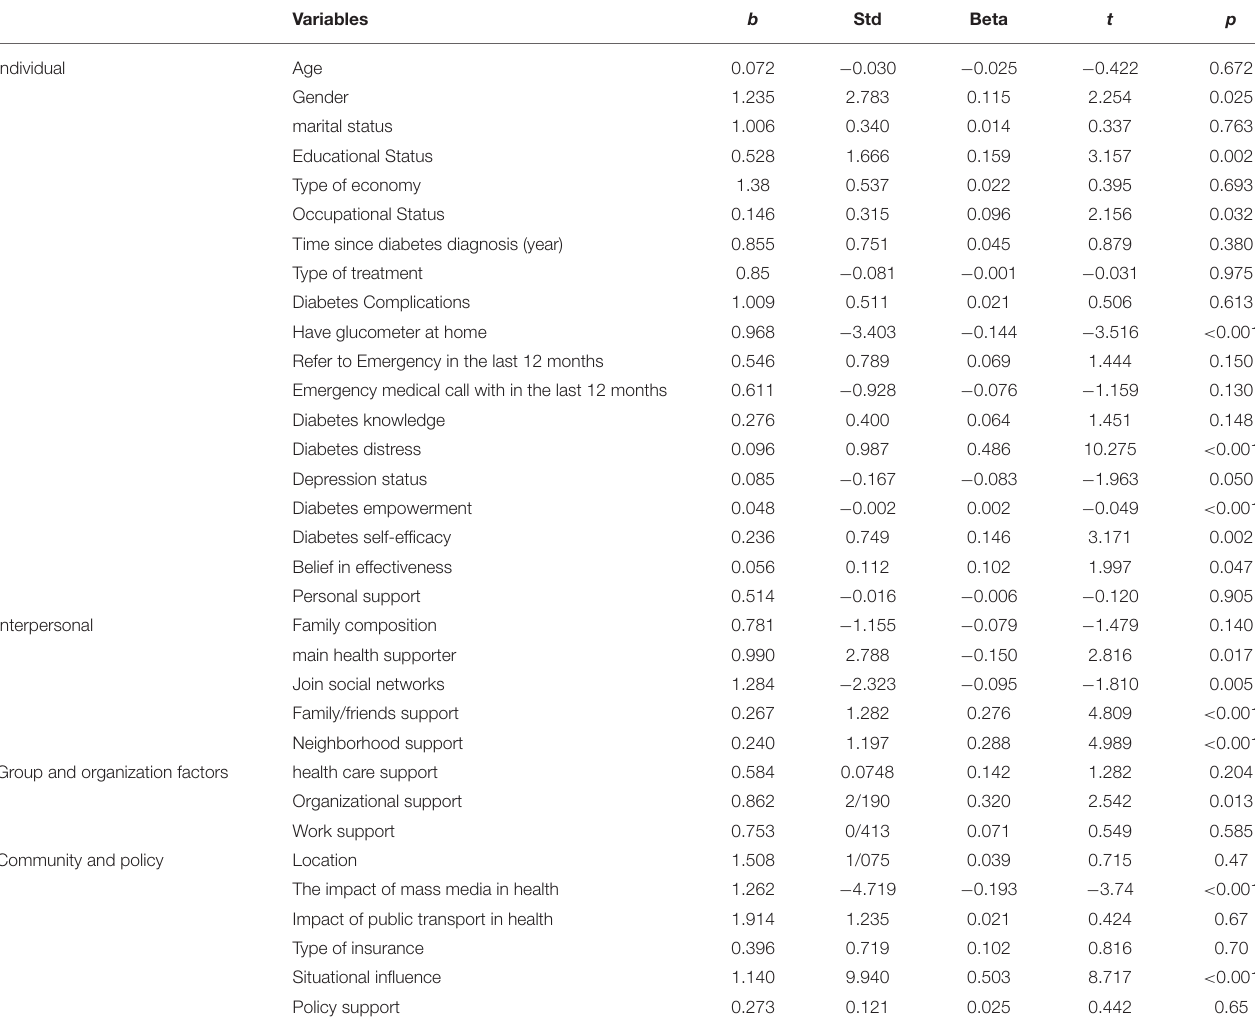
TABLE 3 | Regression analysis of independent variables with self-management of the study population. Variables b Std